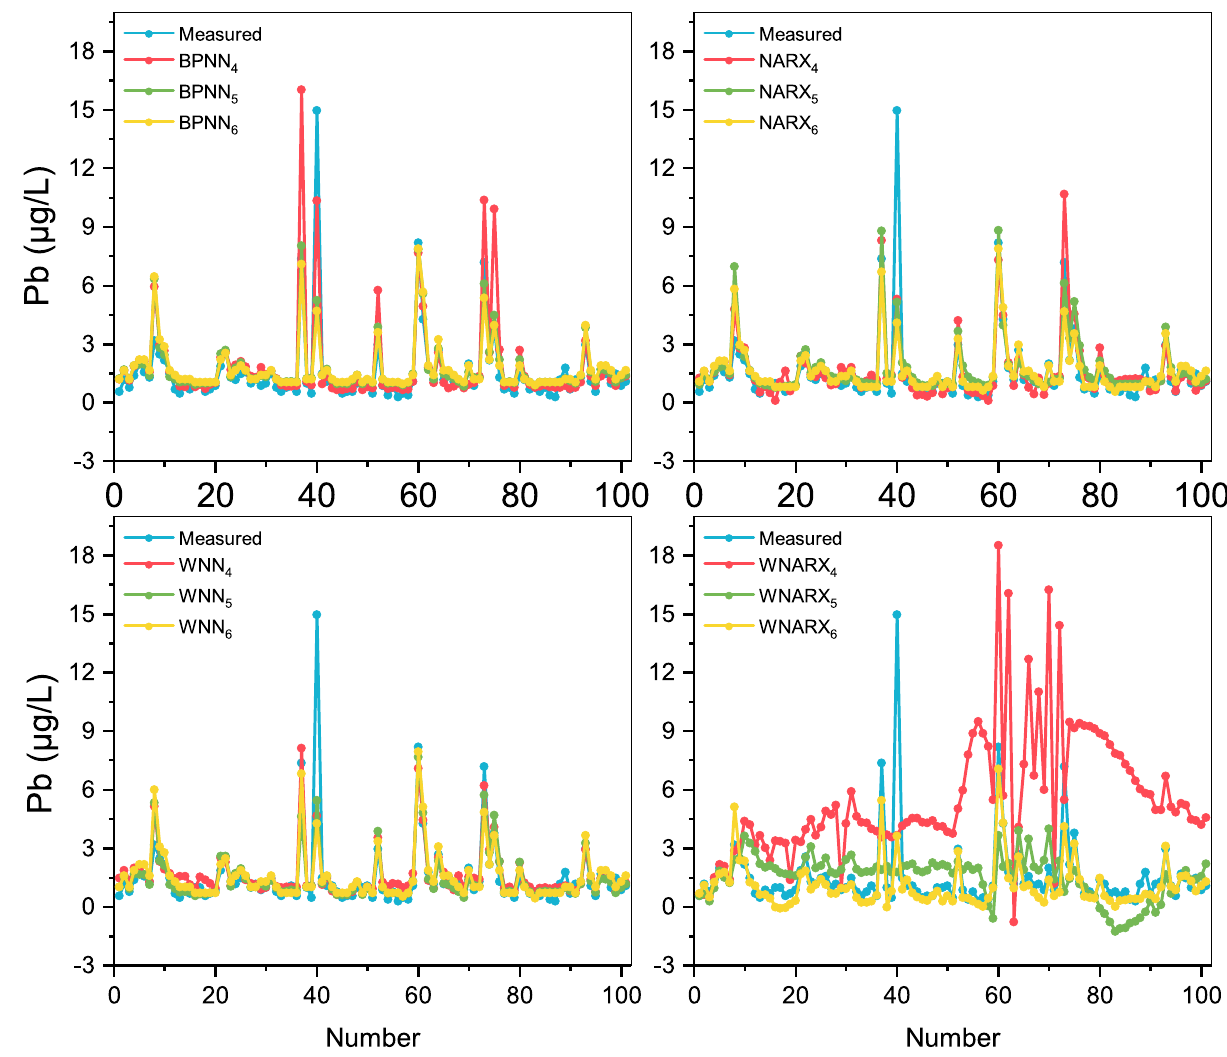
Figure 4. Comparison of the forecasting values and the measured values for Pb. This figure shows the different prediction results for Pb of the settings of the best model parameters in each model algorithm, indicating the concentration of Pb changes within 2 years’ measurement. The red represents the situation with inputs: Fe, flow, pH, NO 3 –N, and EC, the green represents the situation with inputs: Fe and flow, and the yellow represents the situation with inputs: